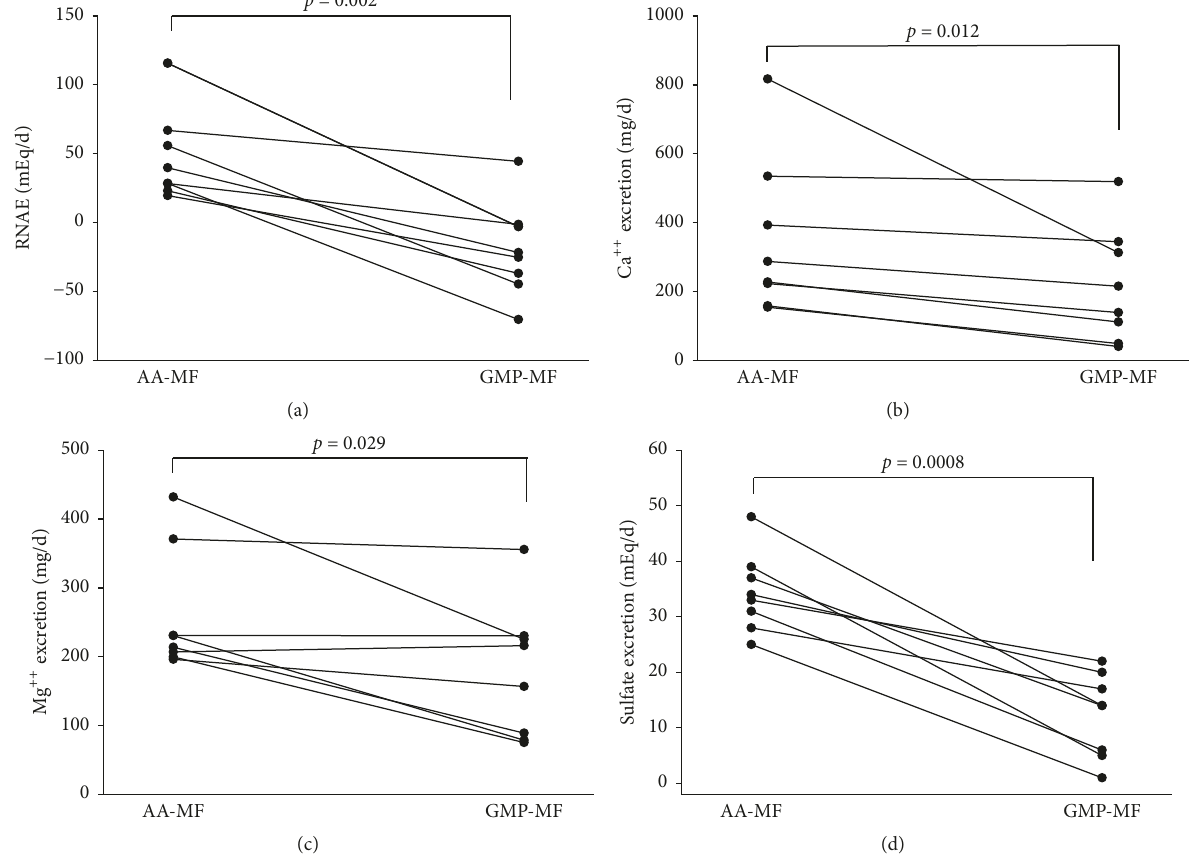
Figure 3: Renal net acid excretion (a), urinary calcium excretion (b), urinary magnesium excretion (c), and urinary sulfate excretion (d), basedon24-hrurinecollectionsinparticipantswithPKUwhoconsumedAA-MForGMP-MF, n =8.Statisticalsignificancereflectssignificant treatment effects, as shown in Figure 2. Results show increases among all 8 participants in urinary excretion of renal net acid, calcium, and sulfate and in 7 of 8 participants in urinary excretion of magnesium with AA-MF compared to GMP-MF. AA-MF, amino acid medical foods; GMP-MF, glycomacropeptide medical